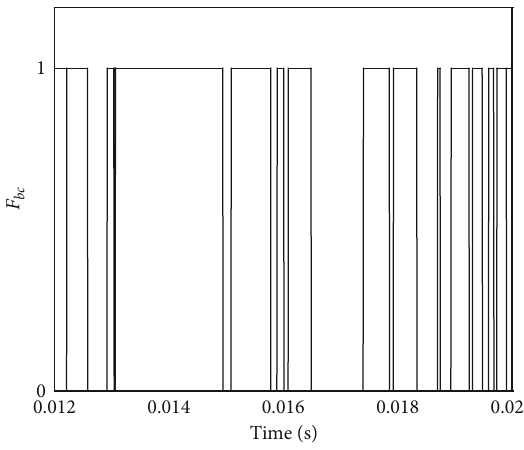
Figure 10: Boxcar in the THM.